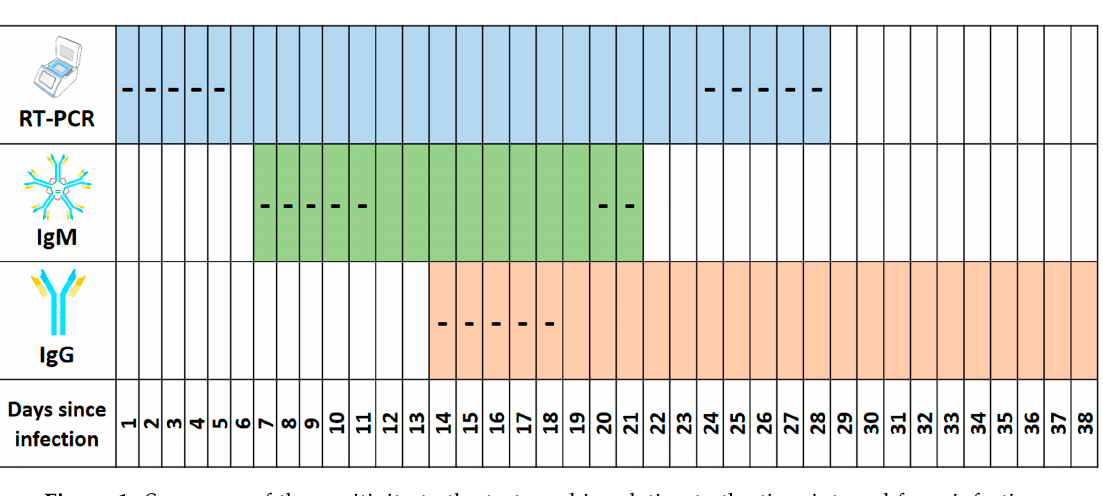
Figure 1. Summary of the positivity to the test used in relation to the time interval from infection: different colors are used for each analysis (blue for RT-PCR, green for IgM antibodies, pink for IgG antibodies. For each test, with the sign (-) the “window” period (number of days when the subject is negative even if he is positive, is reported); moreover, the same sign is used to indicate the last phase of the positivity for the RT-PCR and IgM tests.